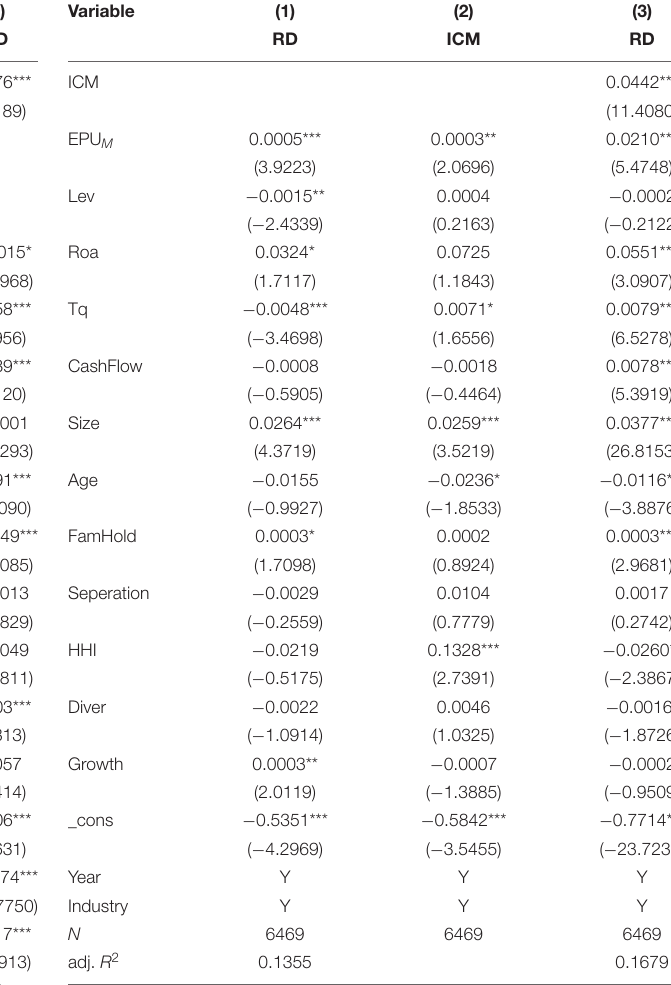
TABLE 6 | Endogenous test and robustness